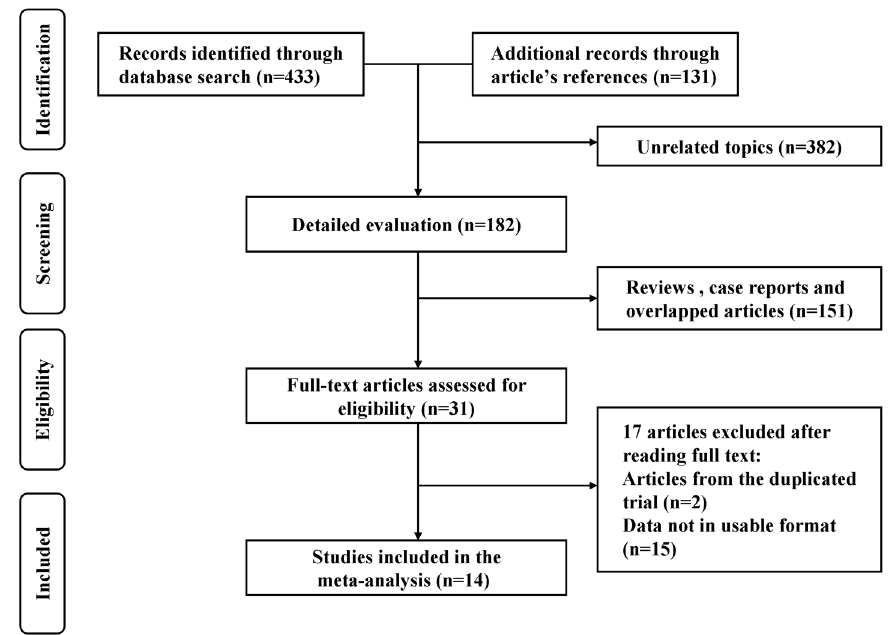
Figure 1. Flow chart of the literature search. A totaol of 14 observational studies (10 case-control and 4 cohort studies) were indemnified in this meta-analysis.